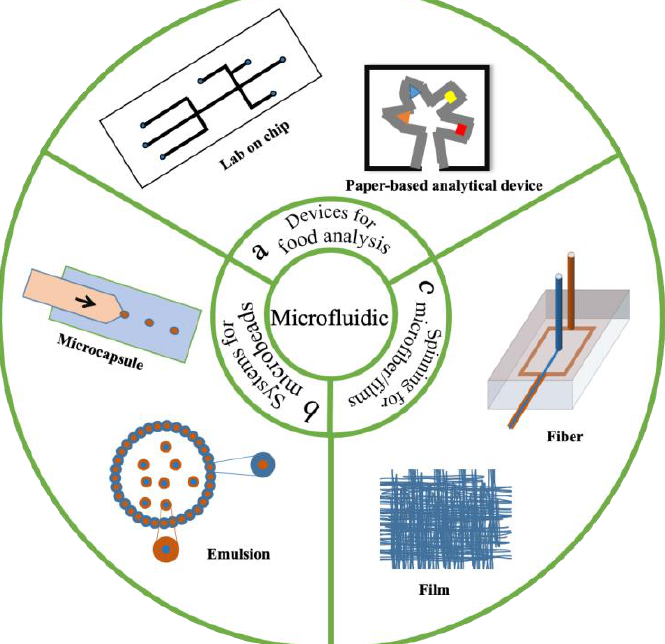
Figure 1. Potential applications of microfluidics in food science and technology. In this review, we conclude that there are three main applications of microfluidics: ( a ) microfluidic chips/devices for food analysis; ( b ) microfibers/films fabricated via MST; and ( c ) microcapsules and emulsions prepared from droplet microfluidic systems.